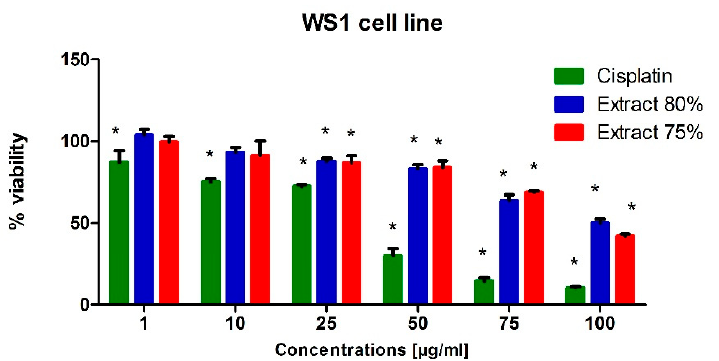
Figure 3. Viability of the WS1 cell line (%) after 24 h of incubation with various concentrations of extract at 80%, extract at 75% and Cisplatin used as reference compound, measured with MTT test; Significant values (*) compared with Cisplatin with p < 0.05 (one-way ANOVA with Tukey’s post hoc test).